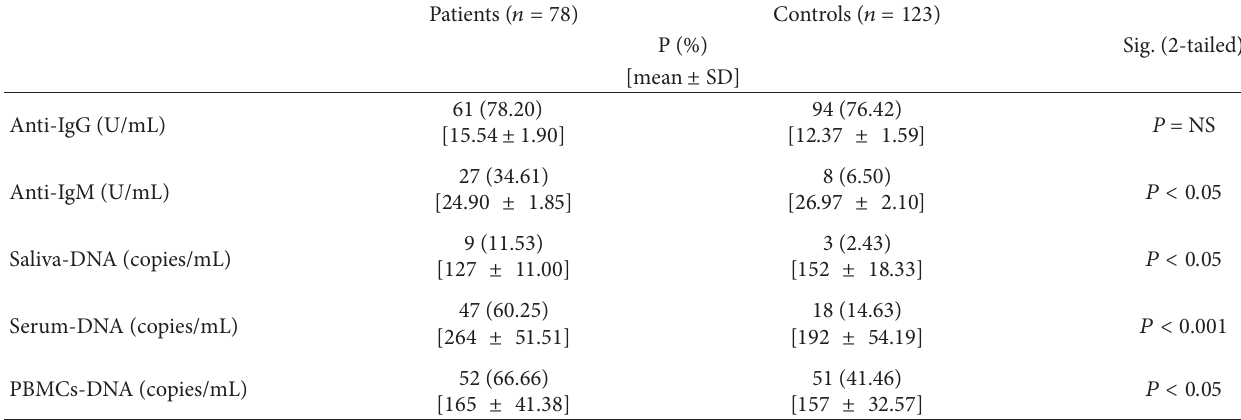
T 1: Prevalence of HHV-6-DNA (copies/mL) and HHV-6-antibodies (U/mL) among controls and MS patients. HHV-6-DNA was analyzed in serum via qPCR as described previously. Concentration of plasma anti-HHV-6, IgG and IgM were measurement in an automated instrument, according to the manufacturer’s instructions. Data are representative of three independent experiments.